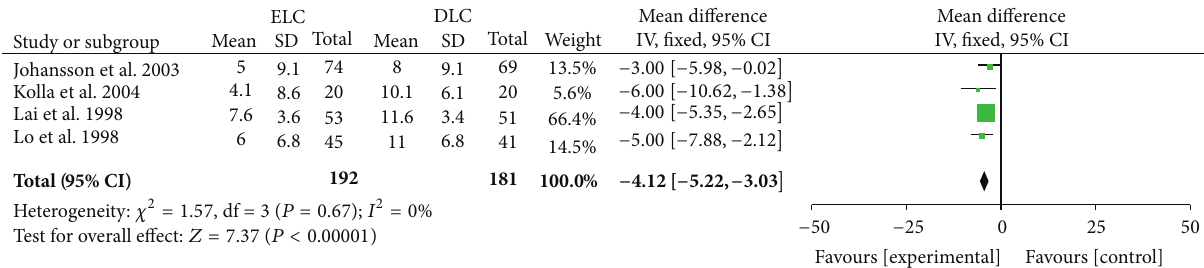
Figure 4: Meta-analysis of total hospital stay in ELC versus DLC. Risk ratio shown with 95% confidence intervals.